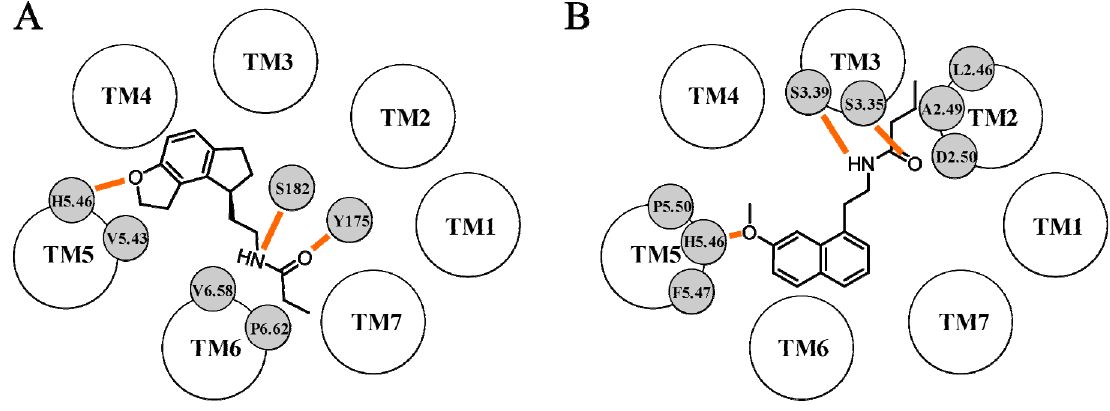
Figure 4. Representation of the binding scheme proposed by Uchikawa et al. for ramelteon ( A ) and by Ivanov et al. for a naphthalene agonist ( B ) within the MT Hydrogen bond interactions are depicted with orange